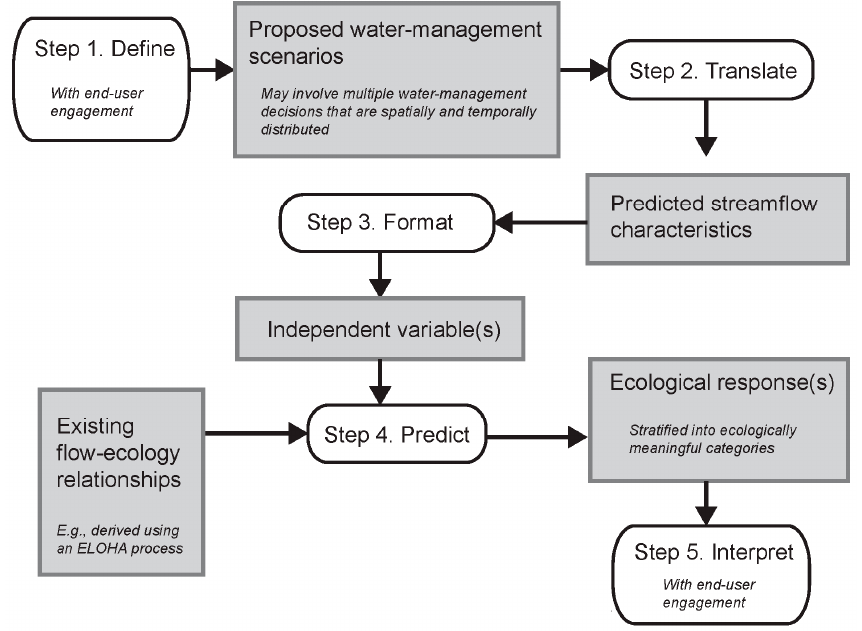
Figure 1. A conceptual model to operationalize flow–ecology relationships into decision-support systems for water-resource managers.